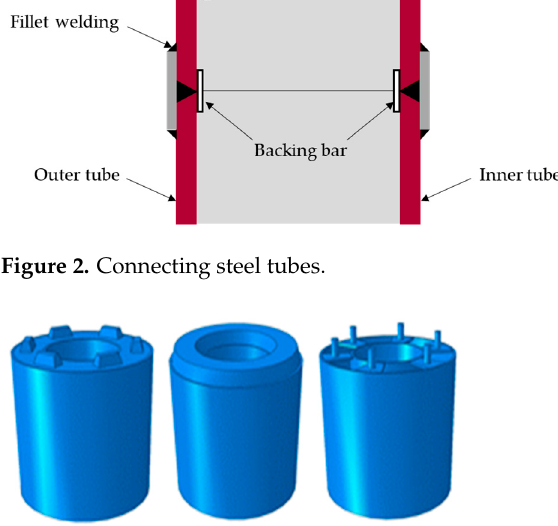
Figure 3. Shear keys for concrete connection ( left : protruding type, middle : doughnut type, right : bolt type).